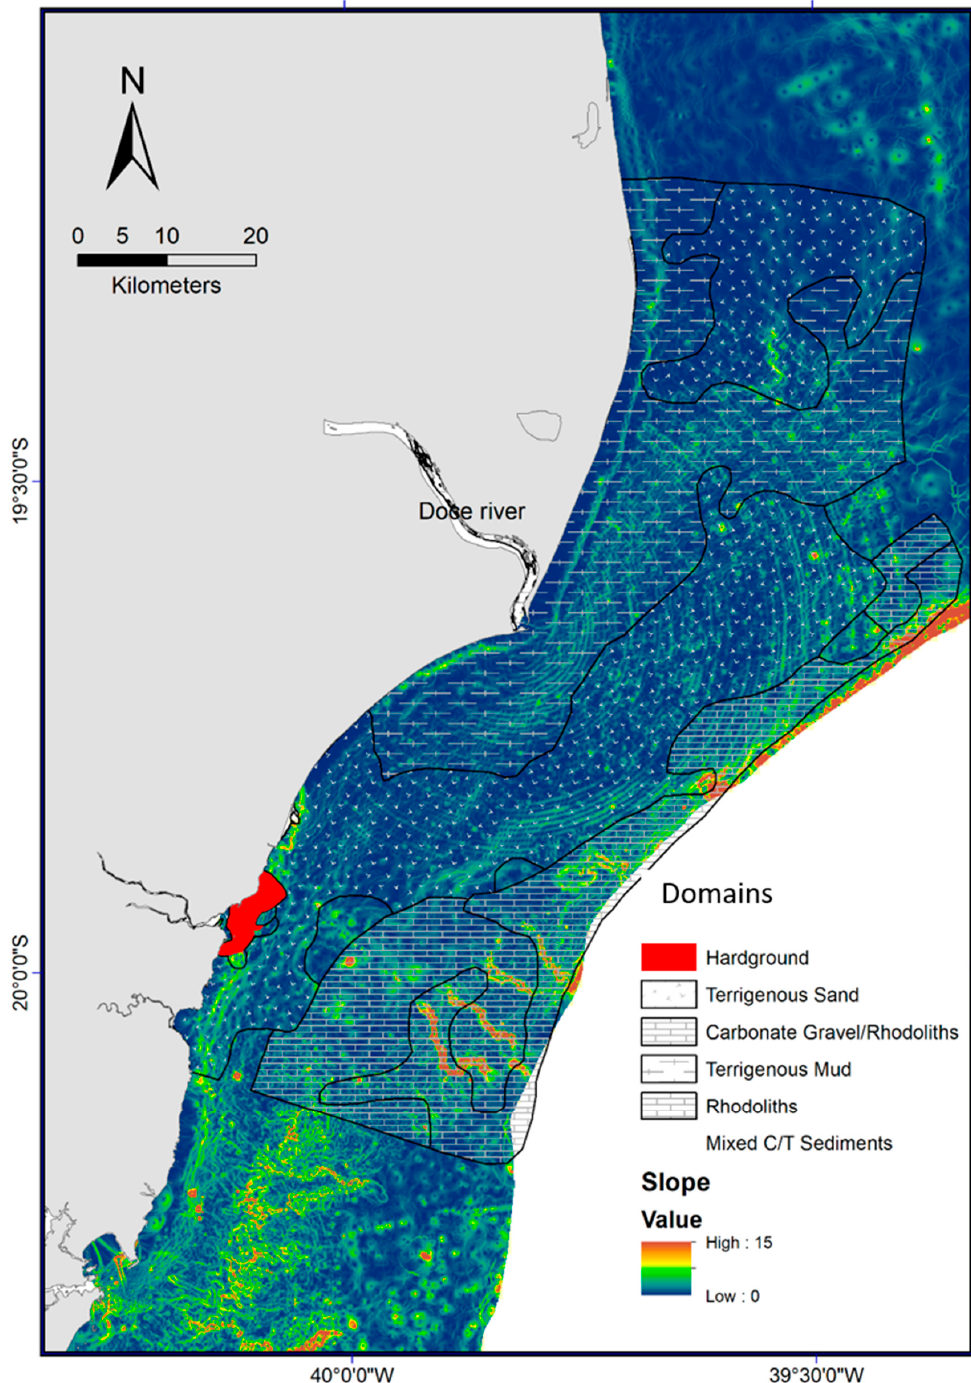
Figure 8. Map combining carbonate and terrigenous domains with a terrain variable (slope).